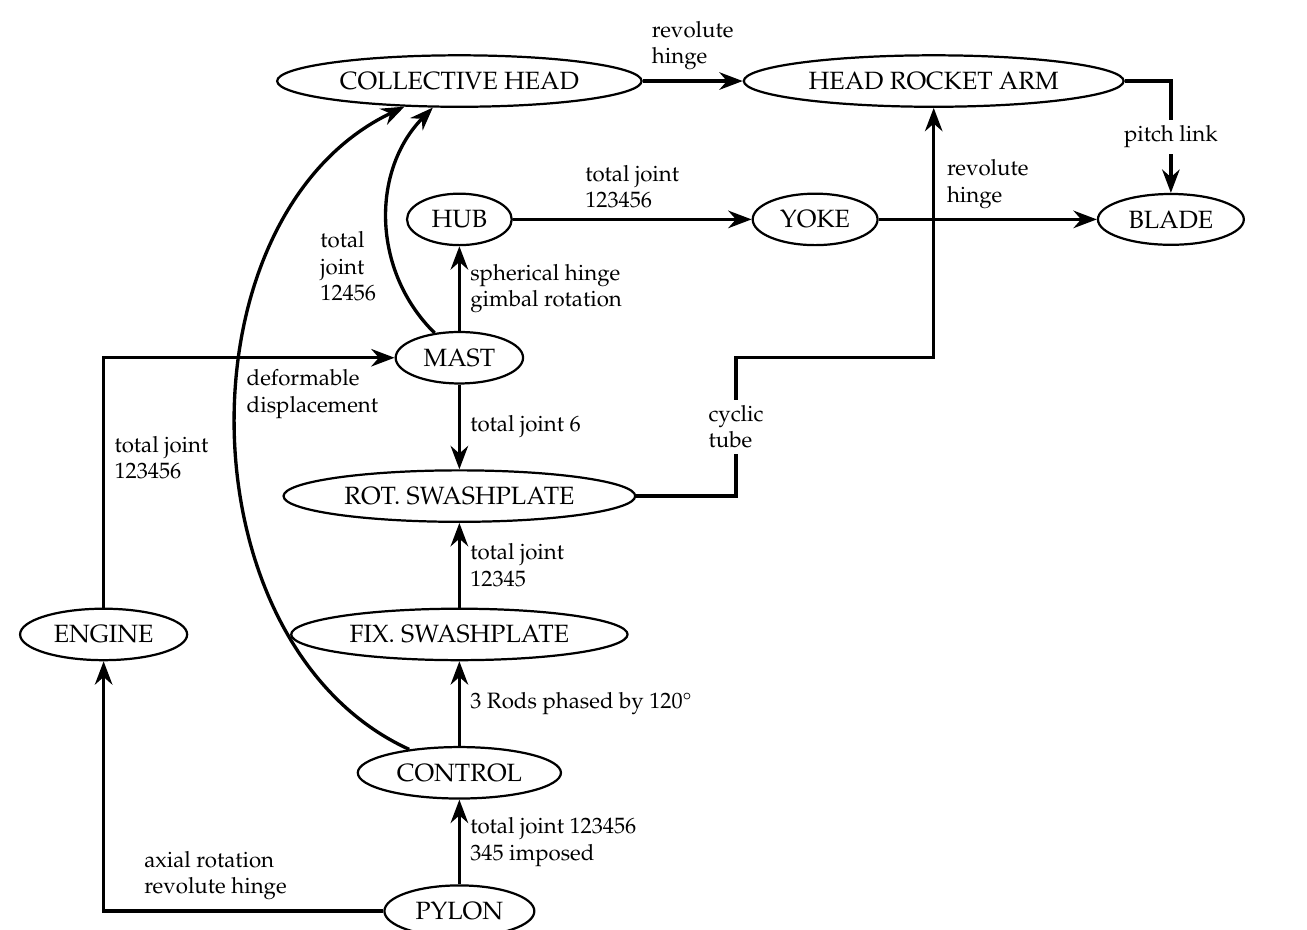
Figure 10. Layout of the XV-15 proprotor control chain.